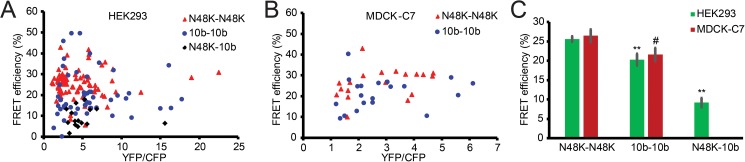
The claudin-10b N48K increases FRET efficiency in cis.(A, B) FRET efficiencies for YFP-claudin-10b WT/CFP-claudin-10b WT interaction (blue), YFP-claudin-10b N48K/CFP-claudin-10b N48K (red) and YFP-claudin-10b N48K/CFP-claudin-10b WT (black) constructs overexpressed in HEK293 cells (A) and MDCK-C7 cells (B) plotted against the YFP/CFP ratio. Only values above the critical YFP/CFP ratio as defined by Milatz et al. (2015) are shown. (C) In HEK293 (** p<0.01) and in MDCK-C7 (# p<0.05) cells average FRET efficiency is significantly higher for YFP-claudin-10b N48K/CFP-claudin-10b N48K interaction than for YFP-claudin-10b WT/CFP-claudin-10b WT interaction. Interaction between claudin-10b N48K/claudin-10b WT is significantly lower than for both claudin-10b N48K/claudin-10b N48K and claudin-10b WT/claudin-10b WT (** p<0.01, only tested in HEK cells). Statistical analysis: MDCK-C7, t-test, n = 19 (WT) and 21(N48K); HEK293, t-test + Bonferroni-Holm, n = 83 (WT), 52 (N48K) and 15 (WT-N48K). Error bars are presented with ± standard error (SEM).